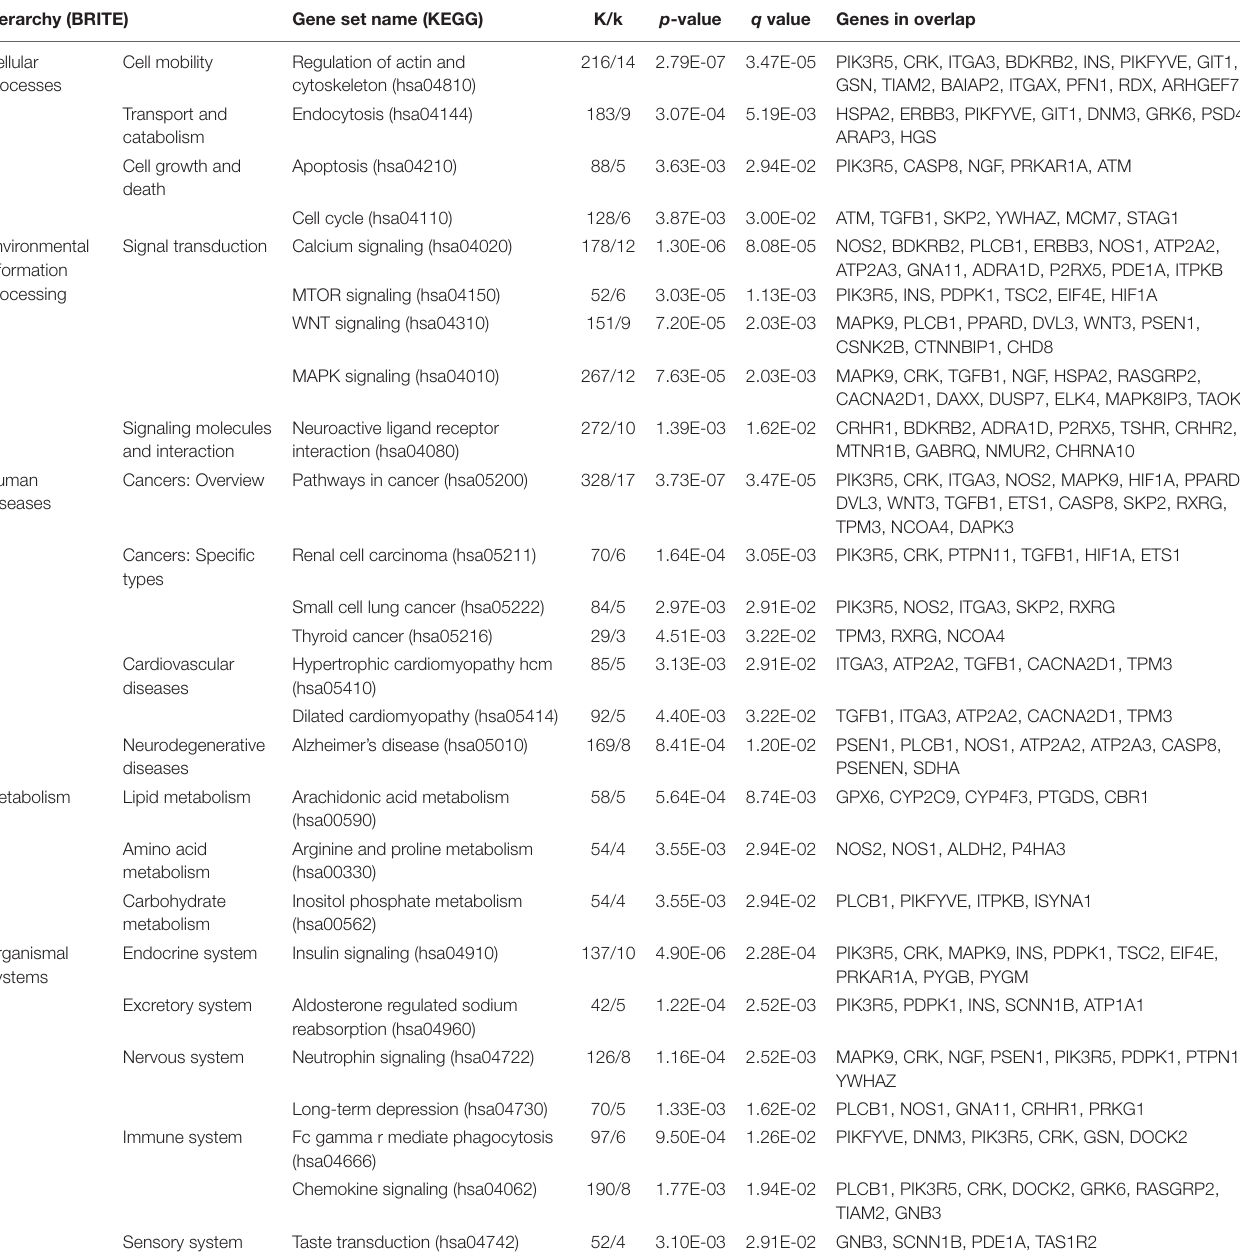
TABLE 2 | Results of the gene set enrichment analysis of the 532-gene overlap with the supervised analysis using the KEGG database and FDR < 0.05. Hierarchy (BRITE) Gene set name